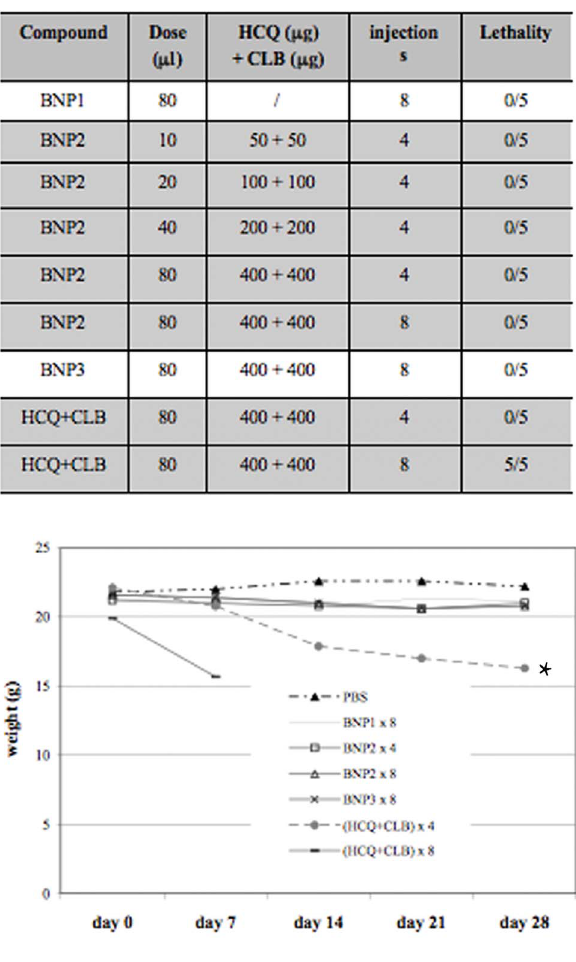
Figure 3. Toxicological studies. C57/BL mice received BNP1, BNP2, BNP3 and HCQ + CLB at different doses. A) Animal survival and B) total body weight was measured for 28 days to evaluate toxicity of the treatments. *: p , 0.001 vs